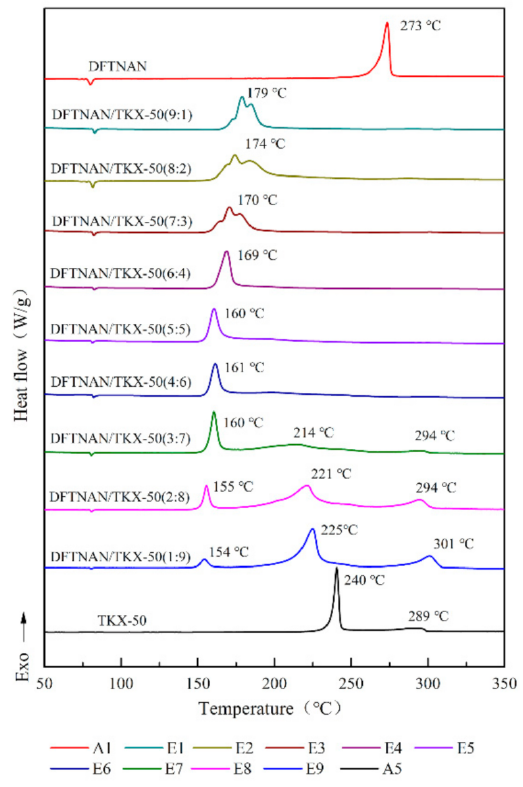
Figure 8. DSC curves of DFTNAN, TKX-50 and mixtures with different